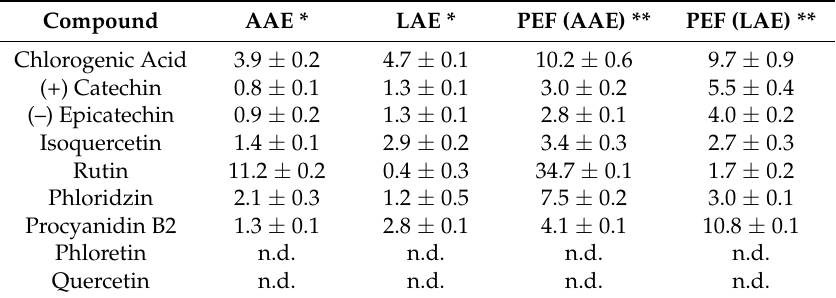
Table 1. Polyphenolic content of AAE and